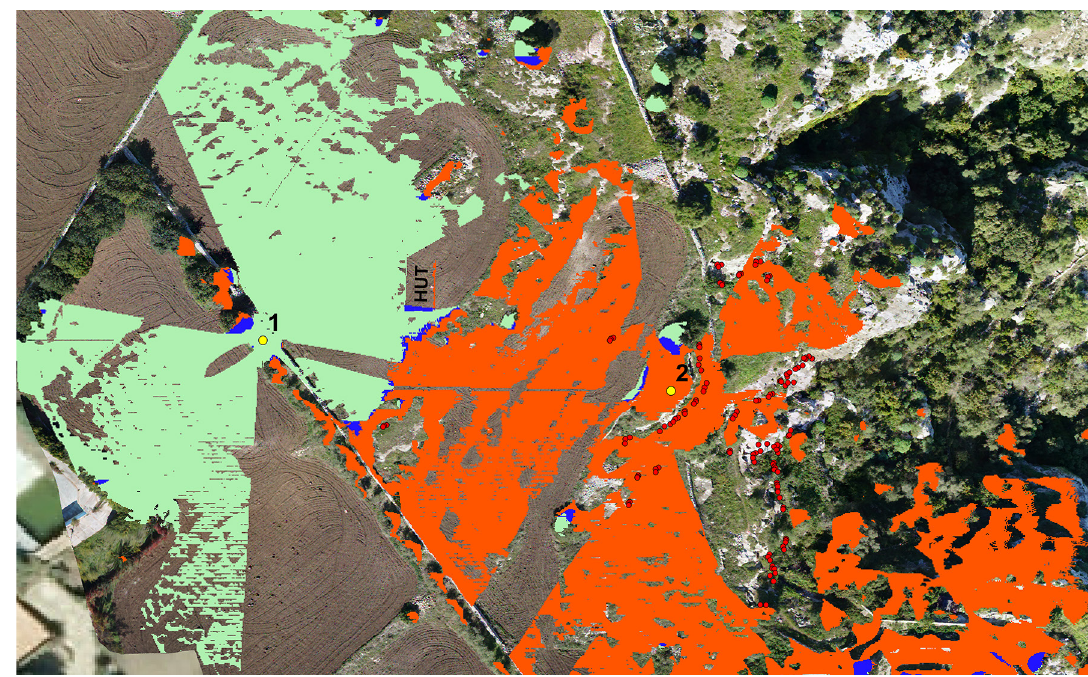
Figure 13. Inter-visibility analysis from two observer points. Observer 1 = village; observer 2 =